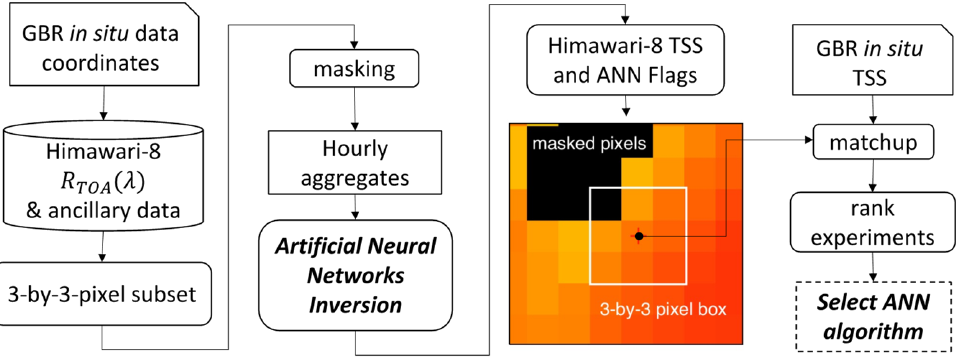
Figure 4. A simplified overview of the algorithm validation procedure.